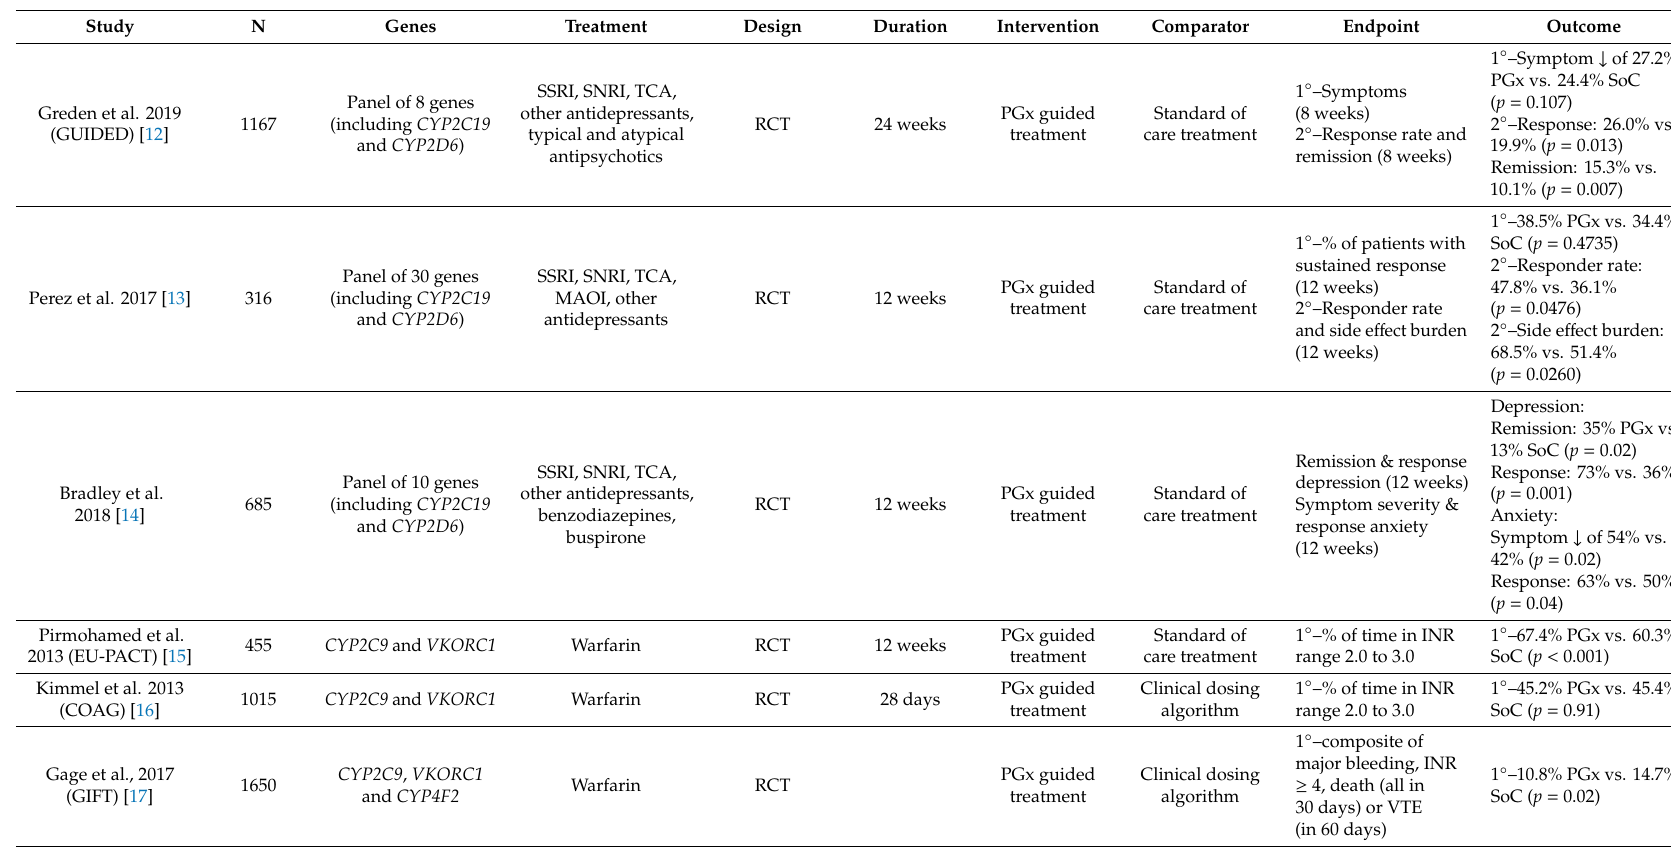
Table 2. A non-exhaustive summary of recent interventional studies investigating pharmacogenomics of relevance to primary care. 1 ◦ = primary endpoint, 2 ◦ = secondary endpoints, RCT = randomised controlled trial, SoC = standard of care